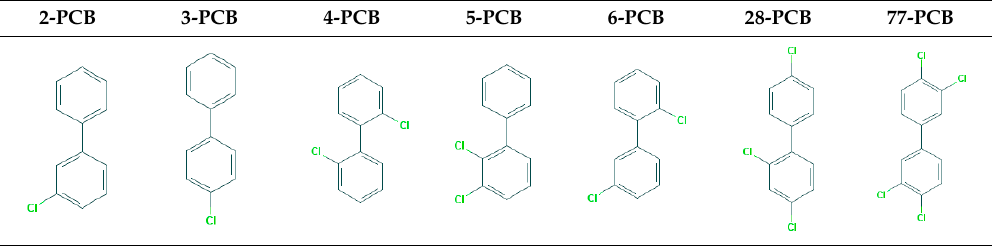
Table 17. Molecular structure of PCB 2, PCB 3, PCB 4, PCB 5, PCB 6, PCB 28, and PCB 77 (obtained from PubChem).